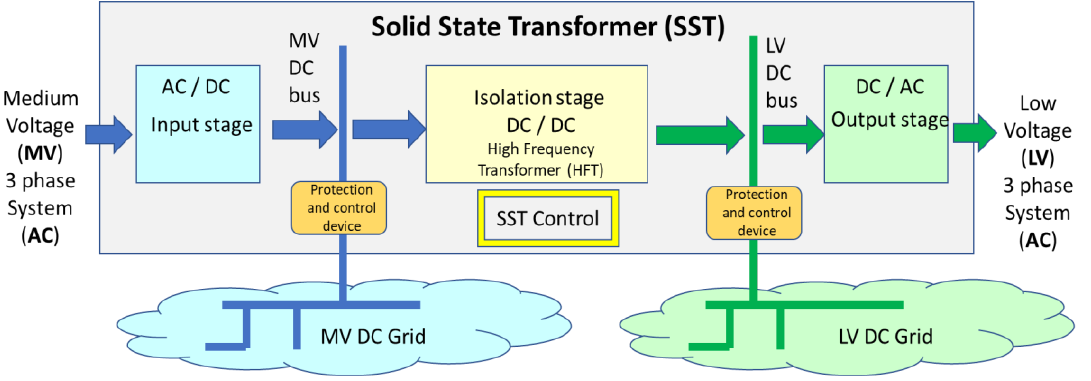
Figure 2. Solid State Transformers (SST) enabling DC grids (medium and low voltage).